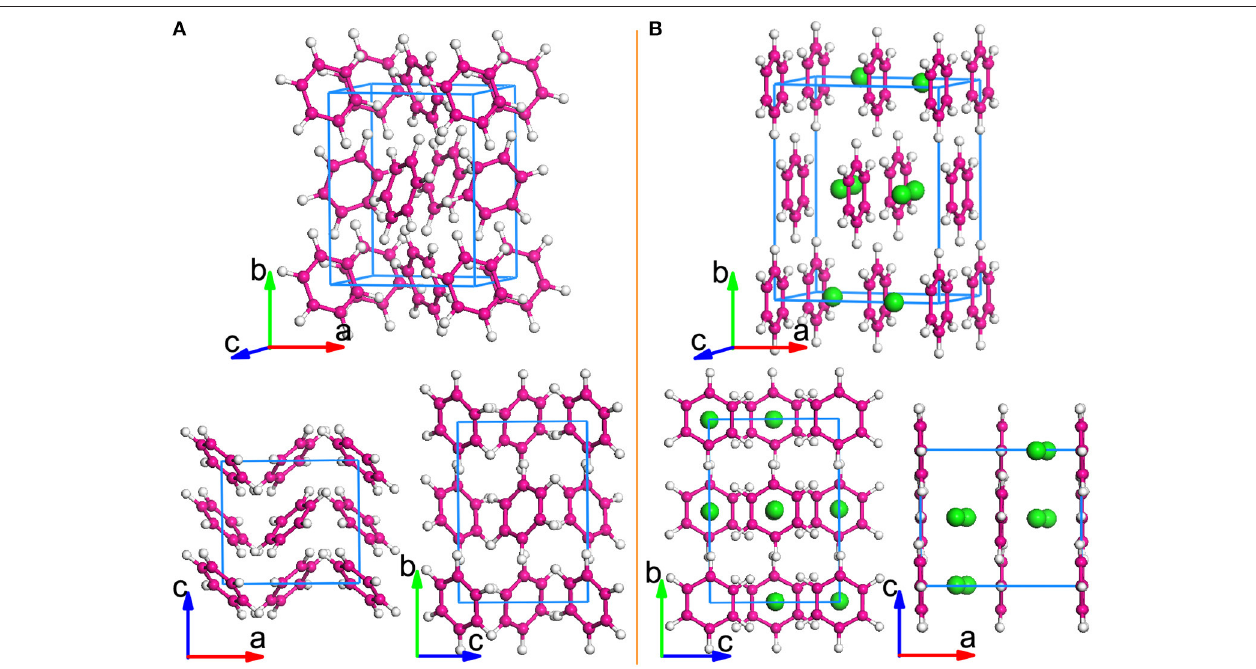
FIGURE 1 | Crystal structures of undoped and K-doped benzene. (A) Optimized crystal structures of solid benzene. (B) Crystal structure of K-doped solid benzene K 2 C 6 H 6 . The structures are viewed from different axial directions. K-atoms are represented by Green